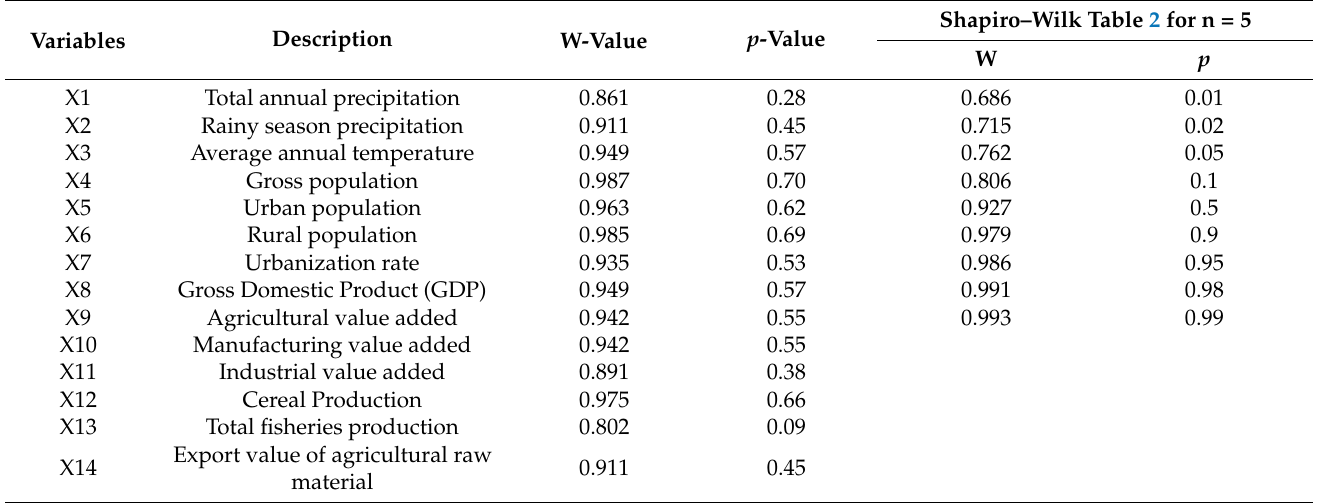
Table 4. Normality test of independent